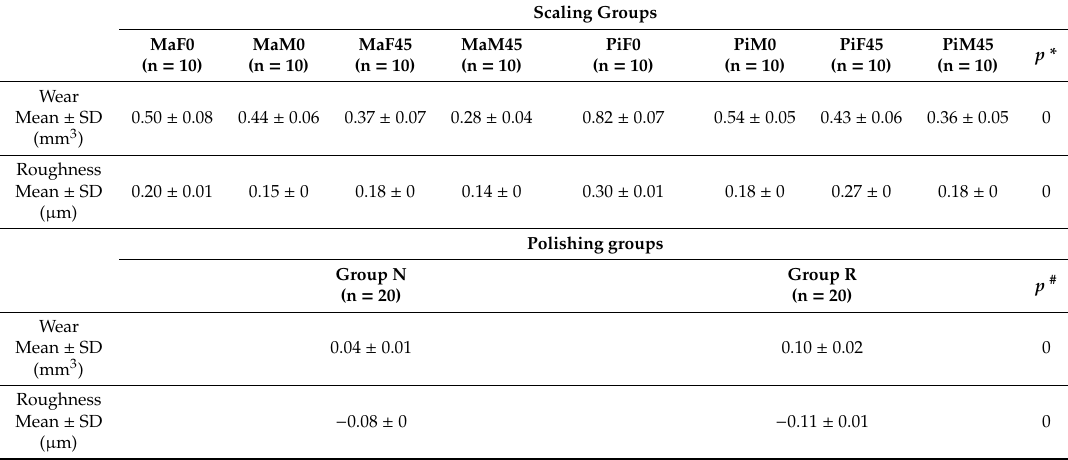
Table 2. Wear and roughness of different ultrasonic scalers and polishing groups.